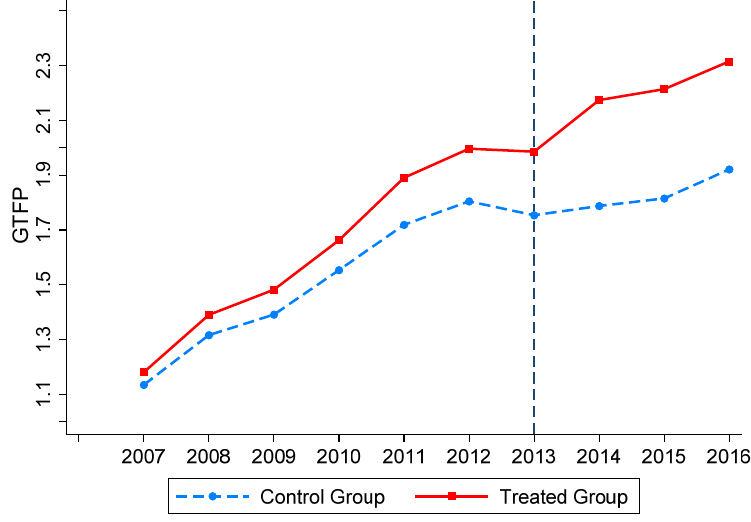
Figure 3. Trends in GTFP of the treated and control groups.